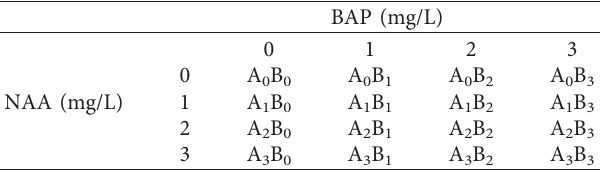
Table 2: The experimental design for micropropagation of Sumatra Benzoin ( Styrax benzoin Dryander) in MS medium with α -naphthaleneacetic acid and benzyl amino